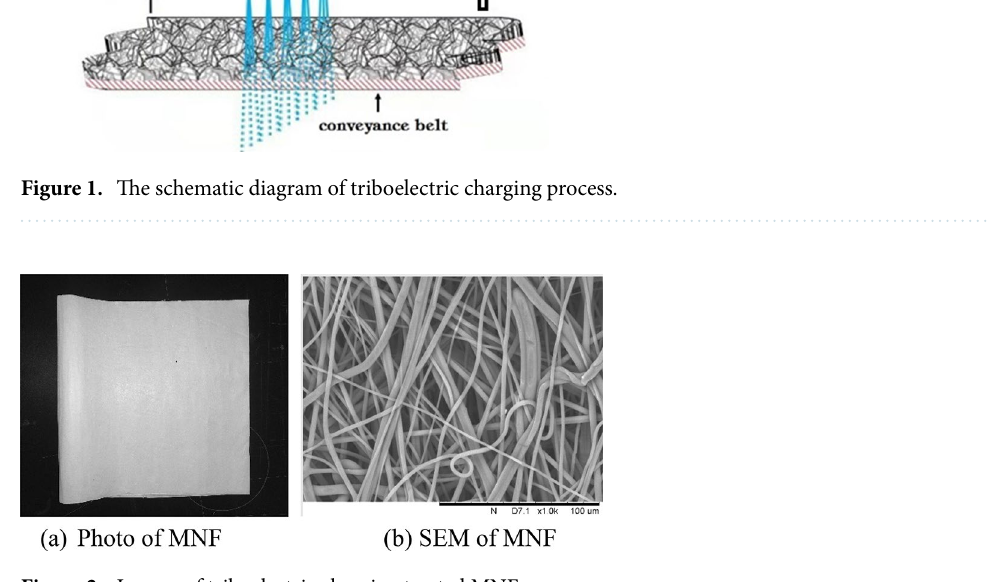
Figure 2. Images of triboelectric charging treated